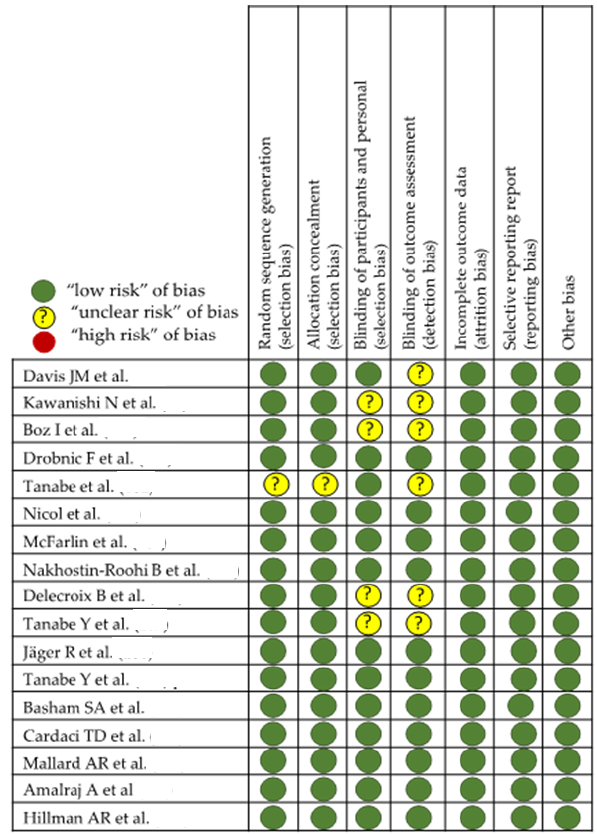
Figure 3. Effect of curcumin on tendinopathy healing [87–96].